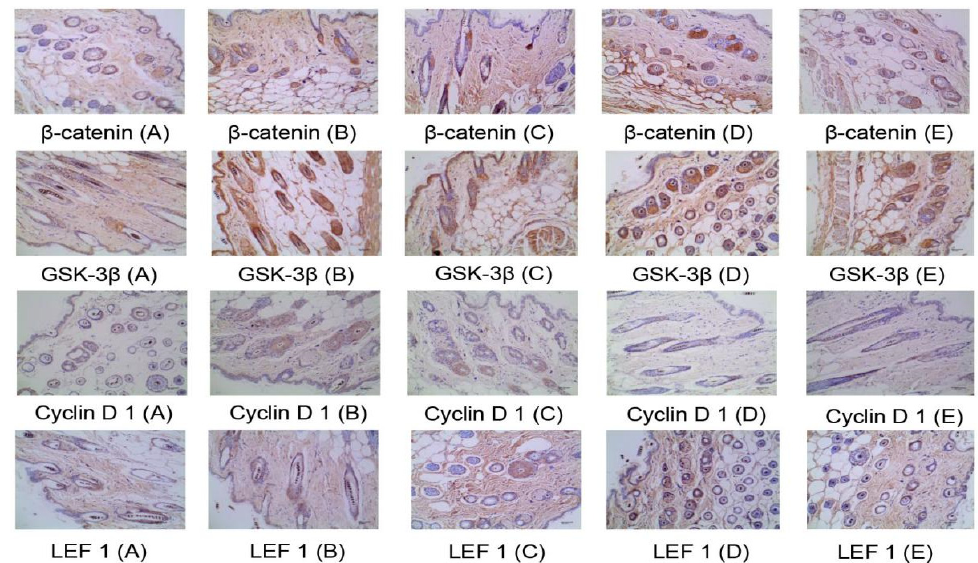
Figure 15. Immunohistochemistry diagram ( × 400). ( A ) Model control group; ( B ). Positive control group; ( C ). β -sitosterol group 2; ( D ). Linoleic acid E group 2; ( E ). Vitamin E group 2.